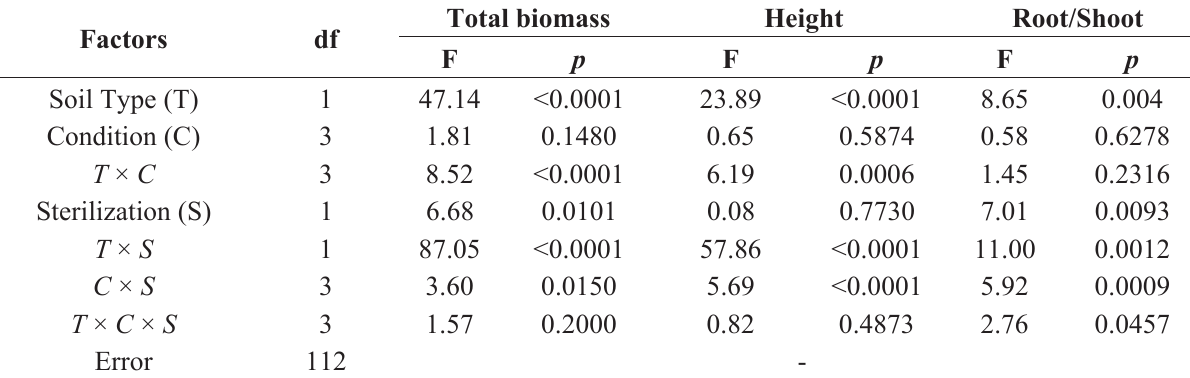
Table 2. Results of three-way ANOVA of soil type, soil conditioning, and soil sterilization on total biomass, root/shoot ratio, and height of Lonicera maackii